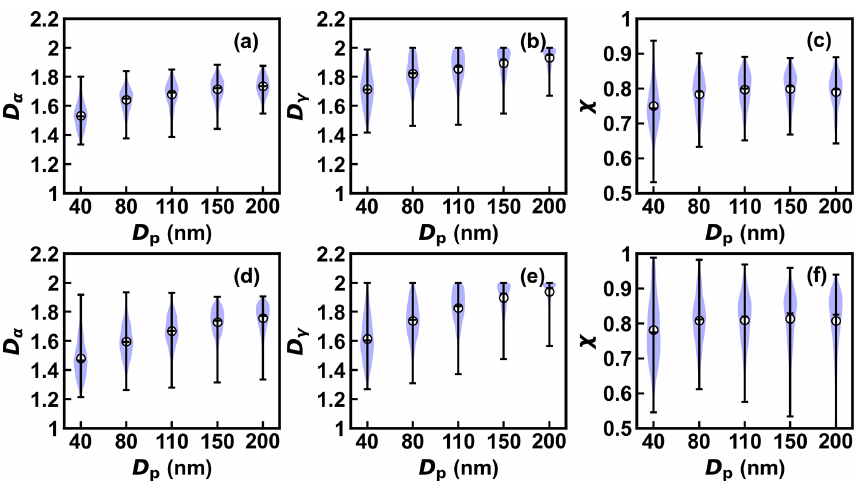
Figure 4. The statistics of D α , D γ , and χ for aerosols of five measured diameters in winter (a) , (b) , (c) and summer (d) , (e) , (f) . The shaded area is the frequency distribution of the indices. The three bars on the whisker for each diameter from the bottom to the top are the minimum, median, and maximum, and the circles represent the average of the